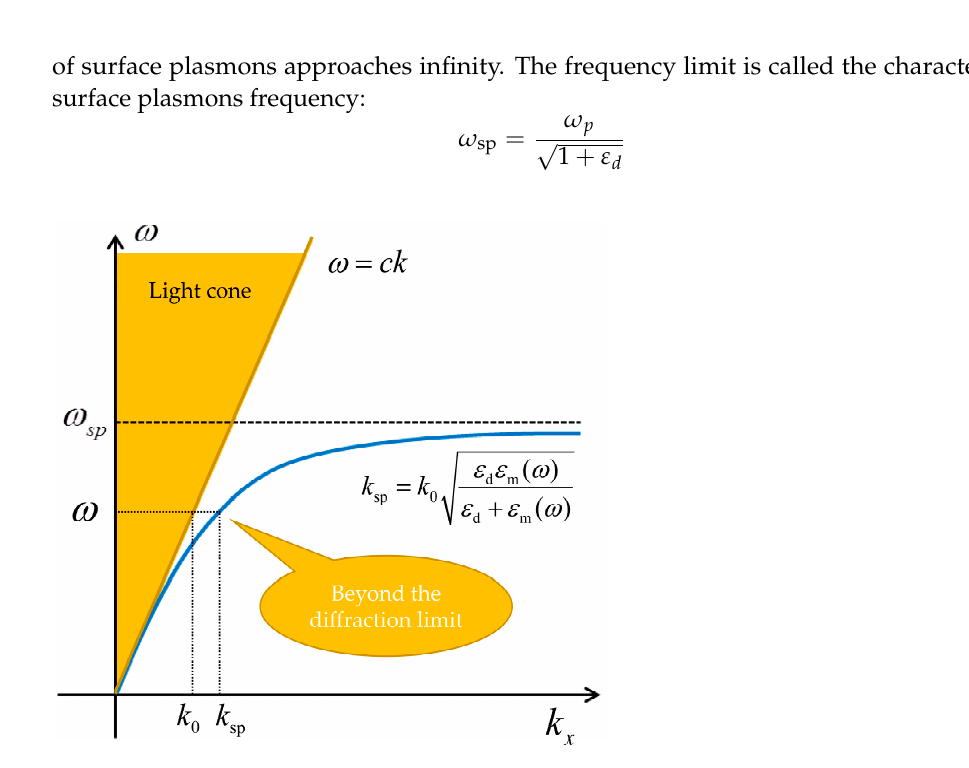
Figure 3. The unique dispersion curve of surface plasmons mode illustrates the momentum mismatch, with the surface plasmons mode lying on the right side of the light line. This yields extraordinary high wave vectors (cid:1863) sp capable of overcoming the diffraction limit of light.